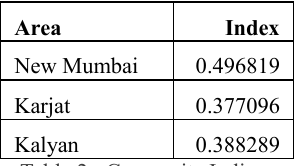
Table 2 : Composite Indices